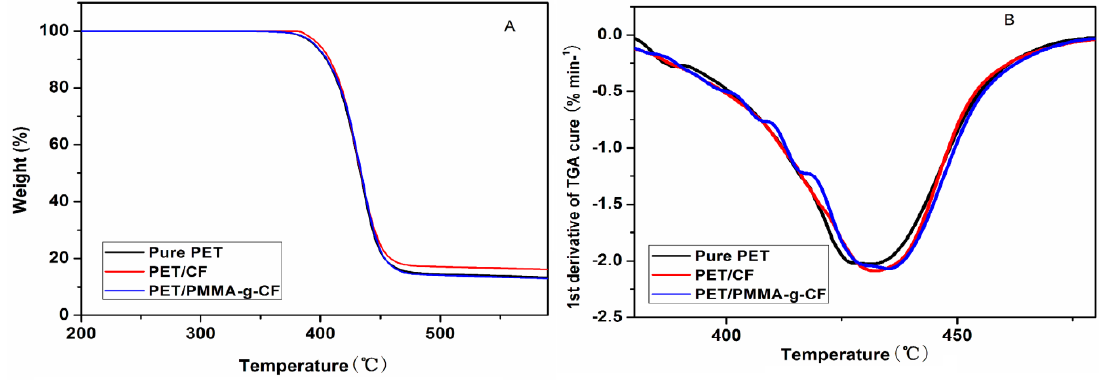
Figure 15. TG and DTG curves of thermal decomposition of pure PET, PET/CF, and PET/PMMA-g- Figure 15. TG ( A ) and DTG ( B ) curves of thermal decomposition of pure PET, PET/CF, and